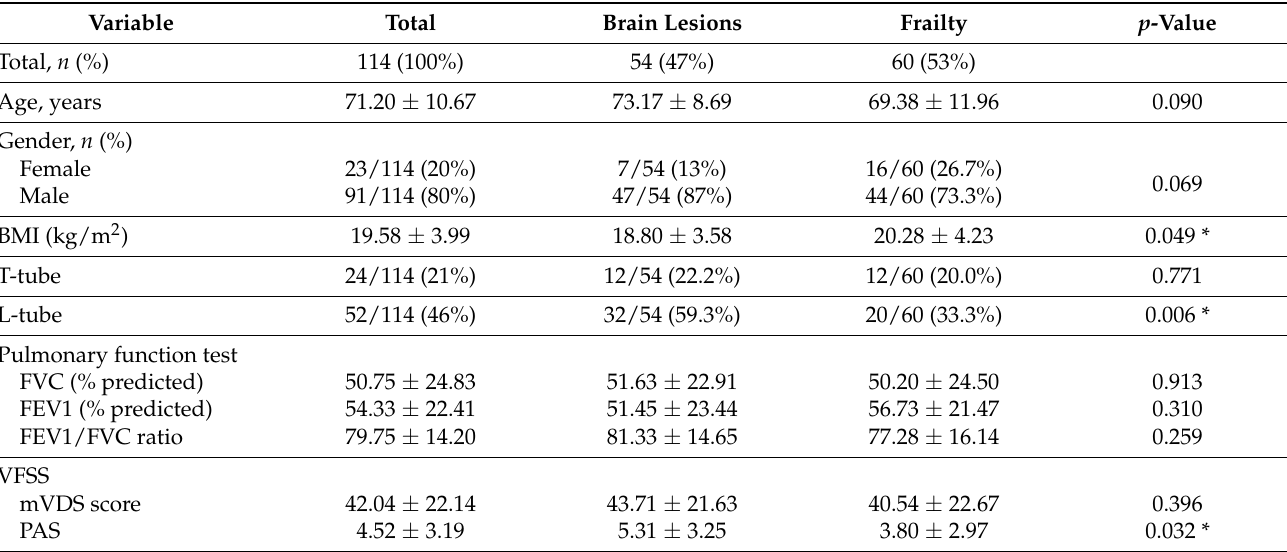
Table 2. Clinical characteristics of the patients with dysphagia who were included in this study.